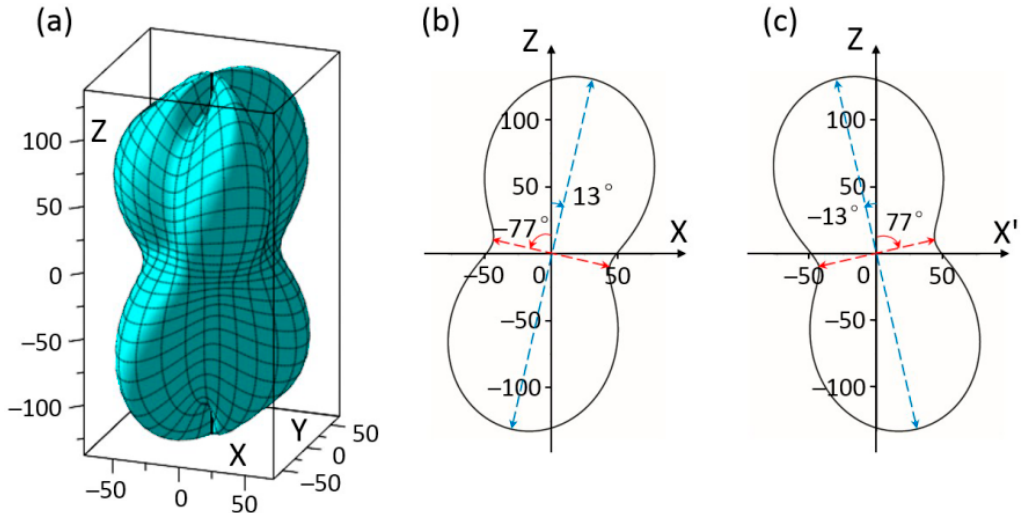
Figure 3. ( a ) Schematic diagram of elastic stiffness c 12 by the experimental data of BiFeO 3 ; ( b ) elastic stiffness c 12 of BiFeO 3 in XOZ plane at φ = 0 ◦ ; ( c ) elastic stiffness c 12 of BiFeO 3 in X ’ OZ plane at φ = 60 ◦ (unit GPa).